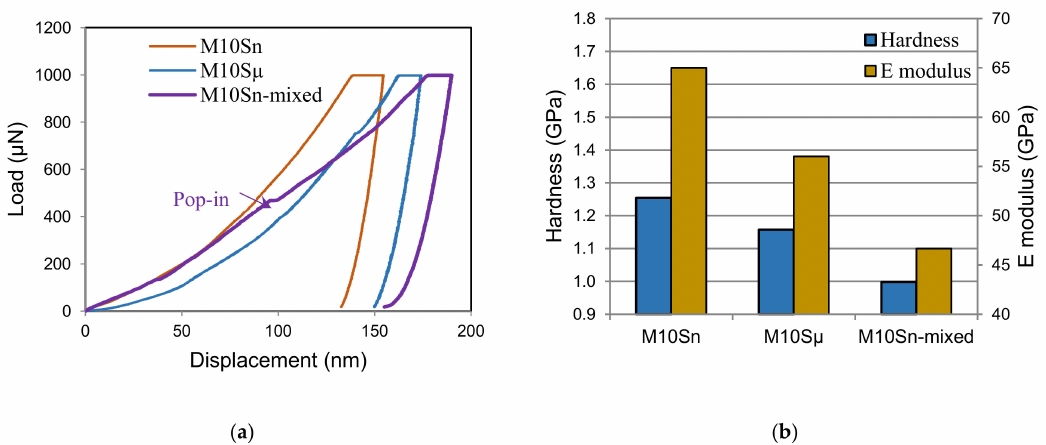
Figure 4. ( a ) Load-displacement curves obtained from nanoindentation experiments with a maximum load of 1 mN and ( b ) mean nanohardness and elastic modulus of M10S n , M10S µ , M10S n -mixed